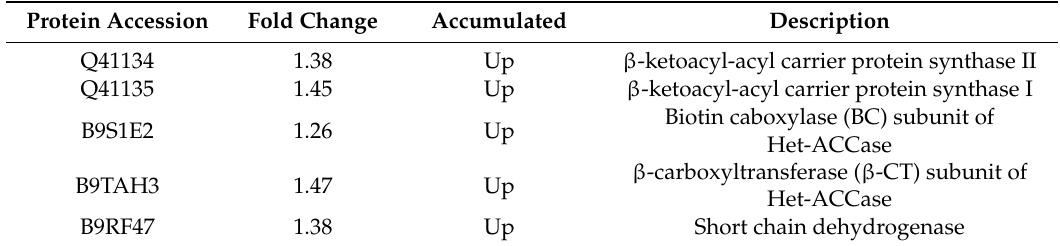
Table 4. Information of DAPS in fatty acid